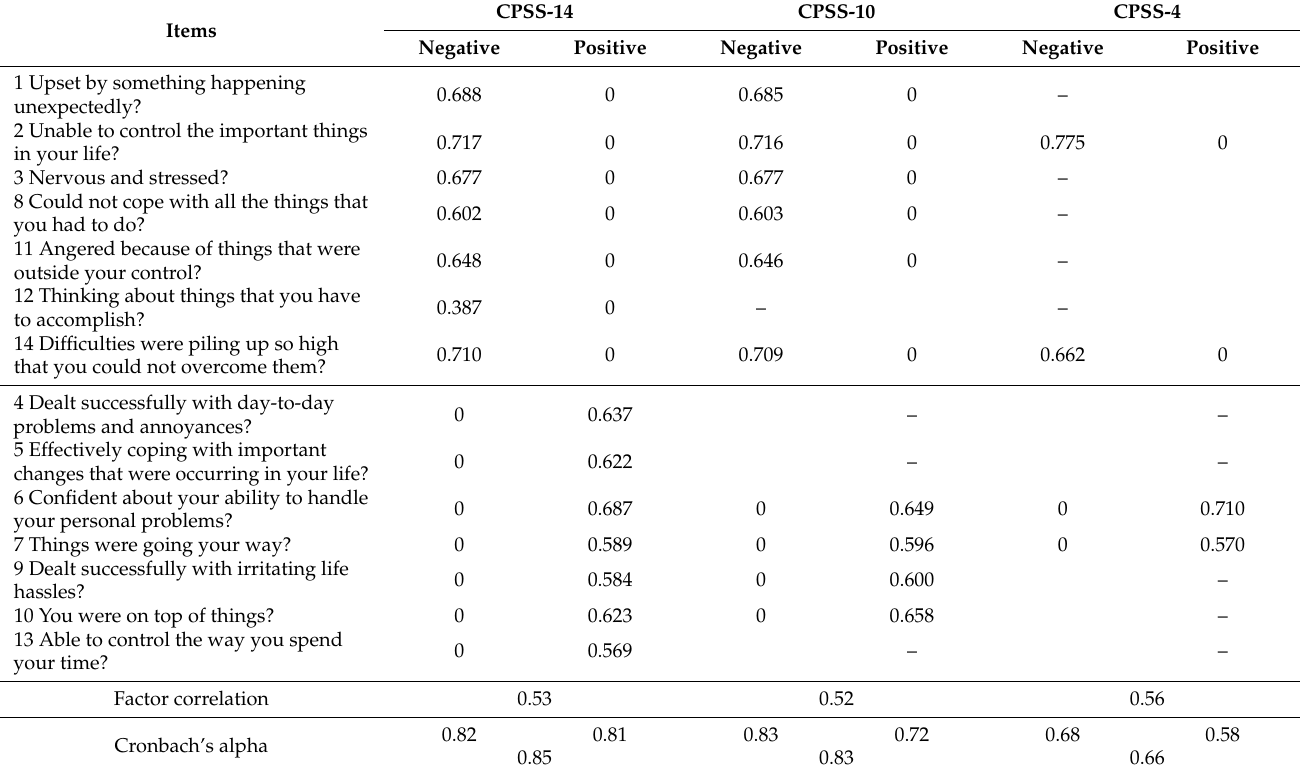
Table 3. Standardized factor loadings for three versions of the